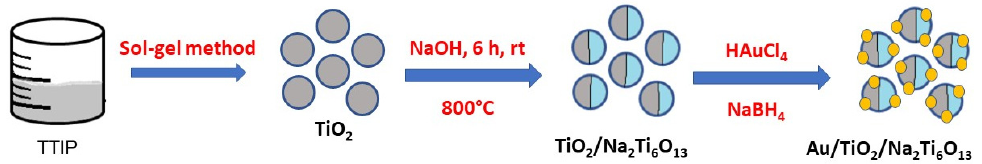
Figure 1. Synthesis preparation for Au/TiO 2 /NTO composites.